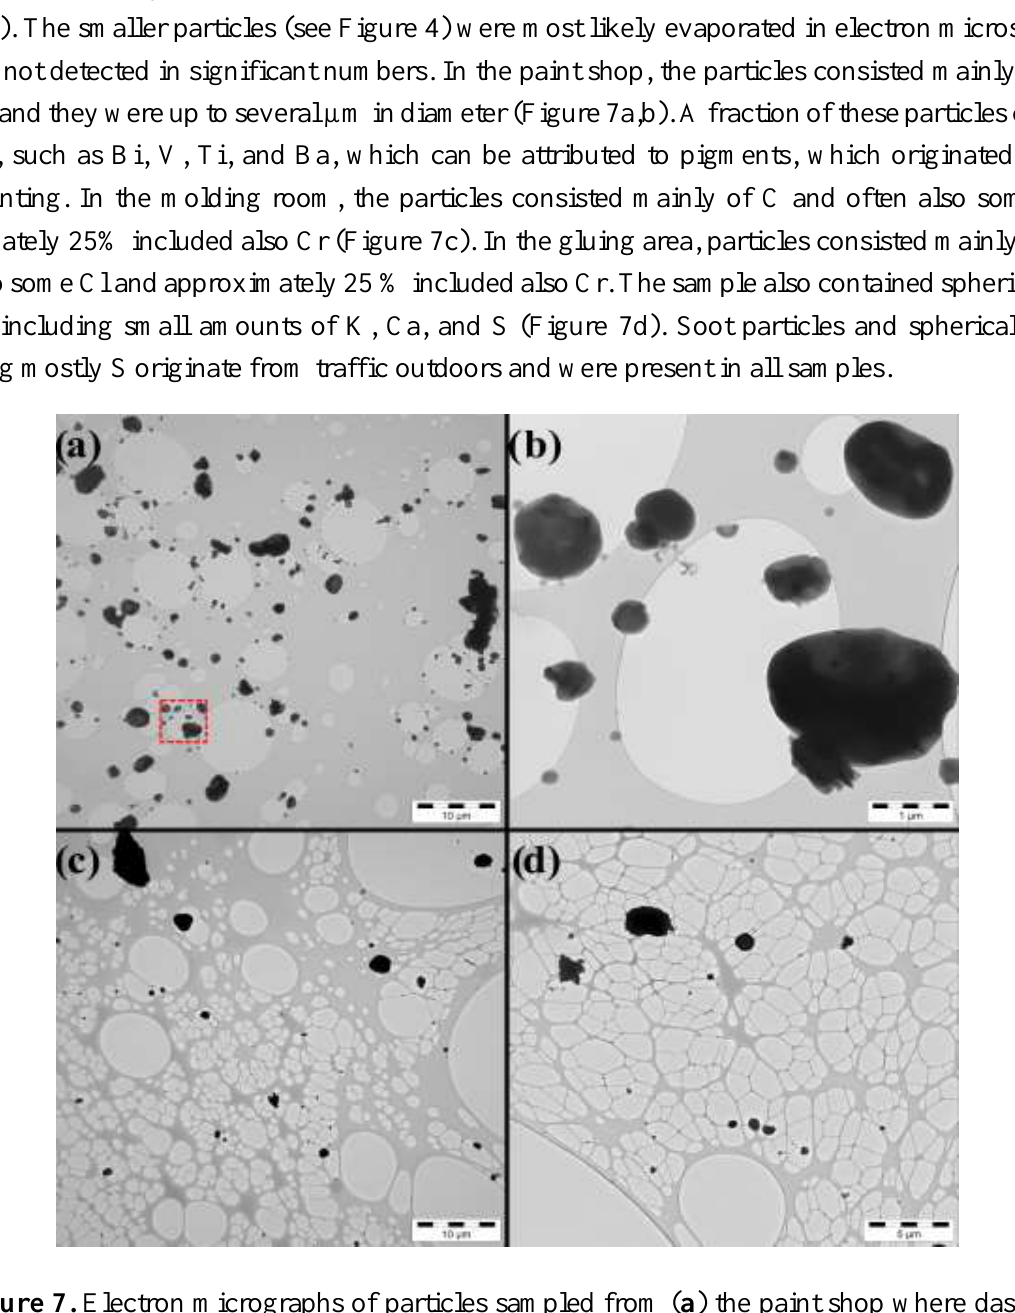
Figure 7. Electron micrographs of particles sampled from ( a ) the paint shop where dashed rectangle is magnified in ( b ), ( c ) the molding room, and ( d ) the gluing